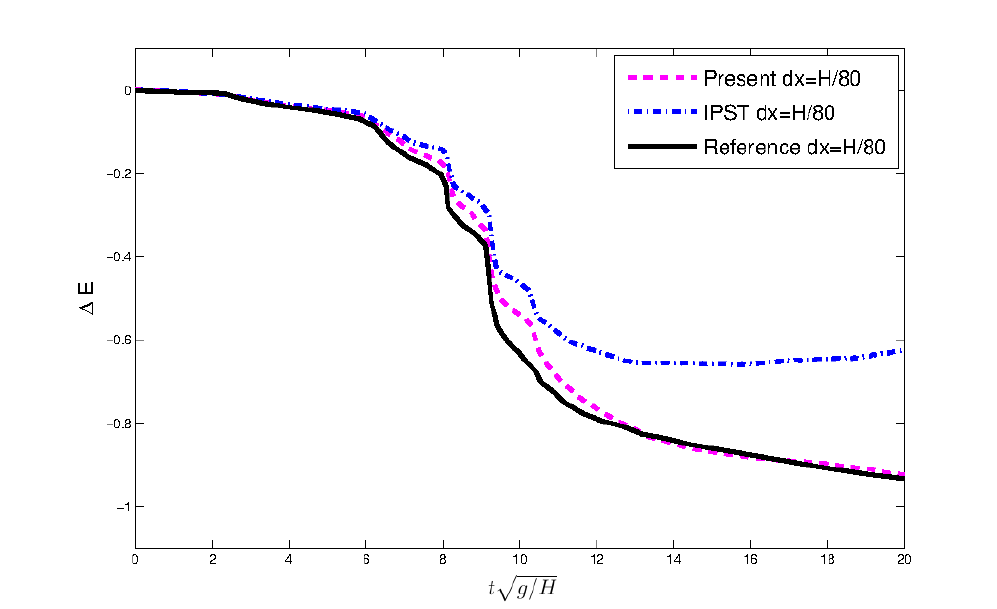
Figure 26. Dam break flow: Time evolution of mechanical energy. The blue dash-dot line represents the results obtained by using IPST [37], whereas for the magenta dashed line presents the results obtained by the present particle shifting formulation. The black reference curve is taken from Marrone et al. [23].